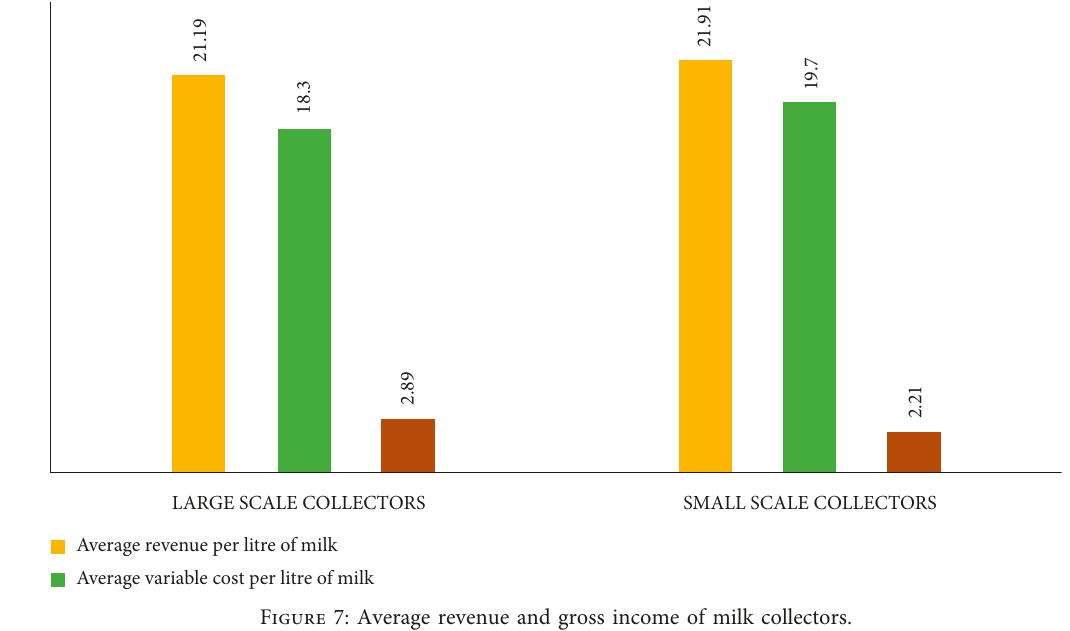
Figure 7: Average revenue and gross income of milk collectors.